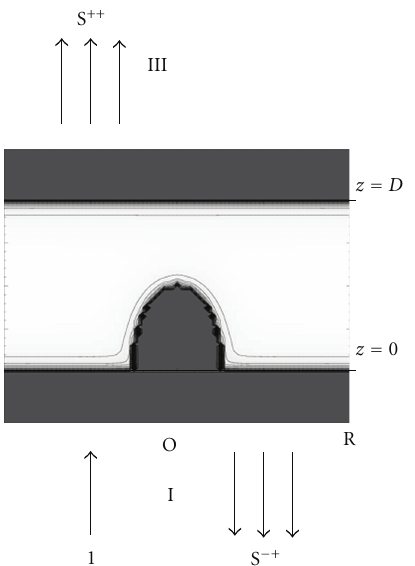
Figure 13: Schematic of theoretical model with protruding tip. D is the electrode separation. The arrows represent the incident and scattered waves used in the transfer-matrix simulation. The arrows in regions I and III symbolize scattering solutions, with a single incident state in region I and the corresponding reflected and transmitted states denoted by S − + and S ++ , respectively [18].